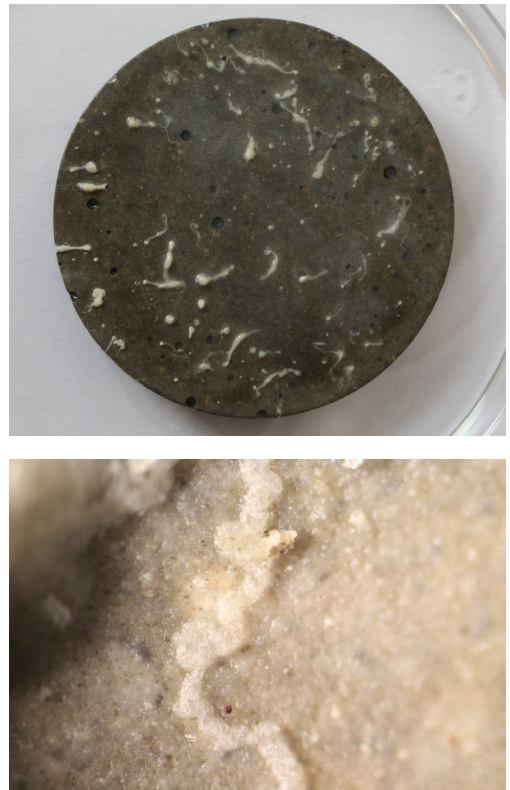
Figure 11. Surface of the specimen placed in solution of bacteria in 253